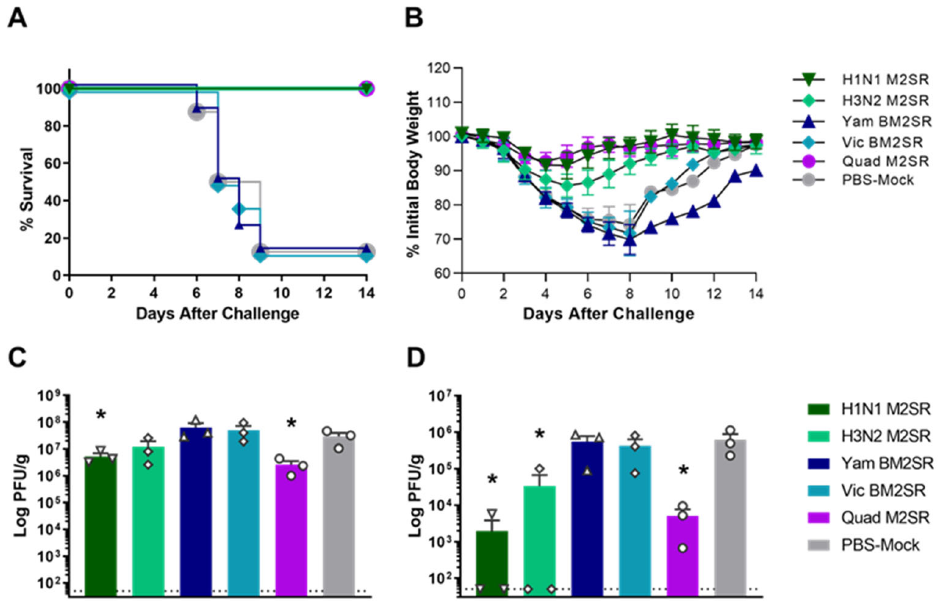
Figure 3. Survival and organ titers of M2SR vaccinated mice following challenge with H3N2 influenza virus. Mice were vaccinated with the indicated vaccines, as described in Materials and Methods. Six weeks following the final vaccination, mice were challenged with 40 MLD 50 of live, wildtype A/Aichi/2/68 (H3N2). Survival ( A ) and body weight changes ( B ) were monitored for 14 days after the challenge. Lung ( C ) and nasal turbinates ( D ) were collected from 3 mice per group on day 4 post-challenge. Viral loads in samples were determined per gram by a plaque-forming assay, and the open faced symbols (e.g., triangles, diamonds, circles, etc.) represent virus titers from individual mice within the group, while colored bars represent the mean titer for the indicated group. The detection limit of the assay was 50 PFU/g and is shown with a horizontal dashed line. Asterisks indicate groups that were significantly different from PBS-mock groups: * p < 0.05 as compared by unpaired t test.